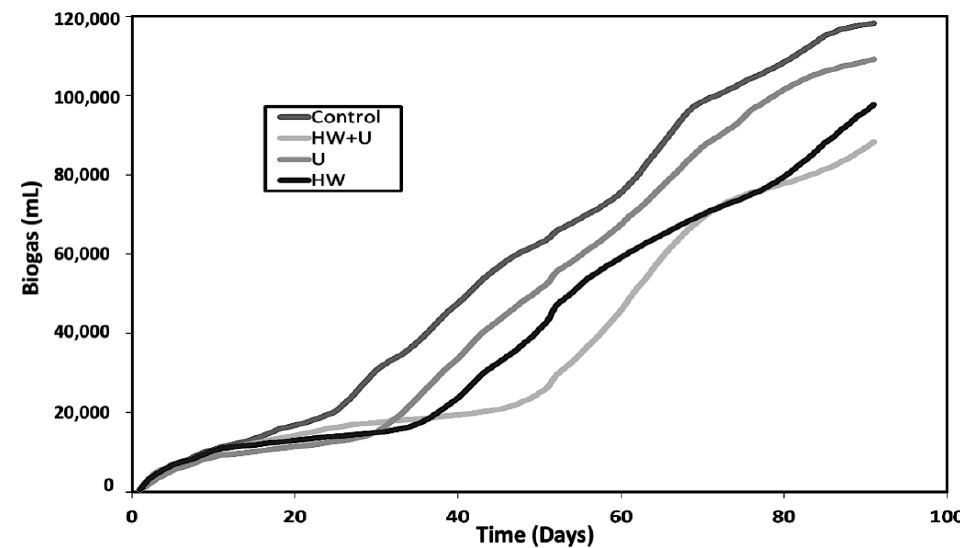
Figure 3. Biogas yield from the digestion of microalgae with different pretreatments.